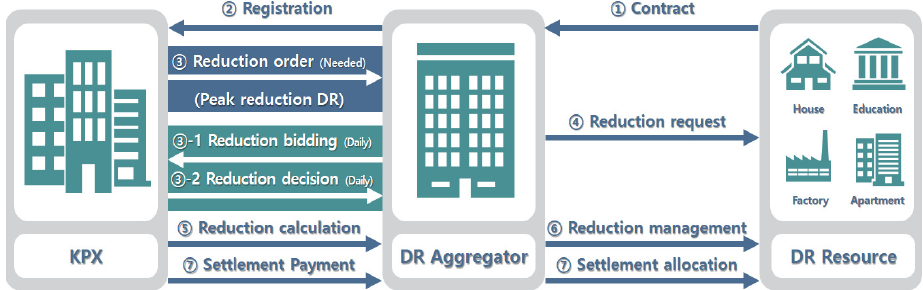
Figure 1. Trading mechanism of a demand response market.